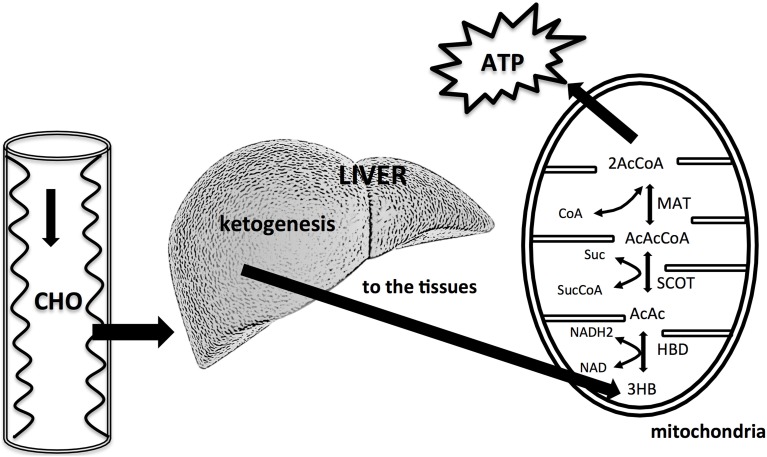
A reduced availability of dietary carbohydrates leads to an increased liver production of KBs. The liver cannot utilize KBs because it lacks the mitochondrial enzyme succinyl-CoA: 3-ketoacid (oxoacid) CoA transferase (SCOT) necessary for activation of acetoacetate to acetoacetyl CoA. KBs are utilized by tissues, in particularly by brain. KBs enter the citric acid cycle after being converted to acetyl CoA by hydroxybutyrate dehydrogenase (HBD), succinyl-CoA: 3–CoA transferase (SCOT), and methylacetoacetyl CoA thiolase (MAT). Modified from Owen (2005), Paoli et al. (2014).